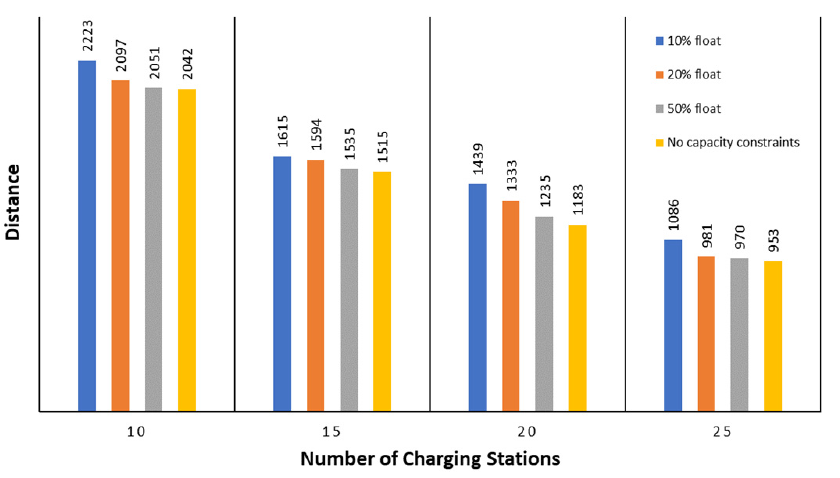
Figure 6. Total distance traveled by EV users as a function of the number and capacity of charging stations.